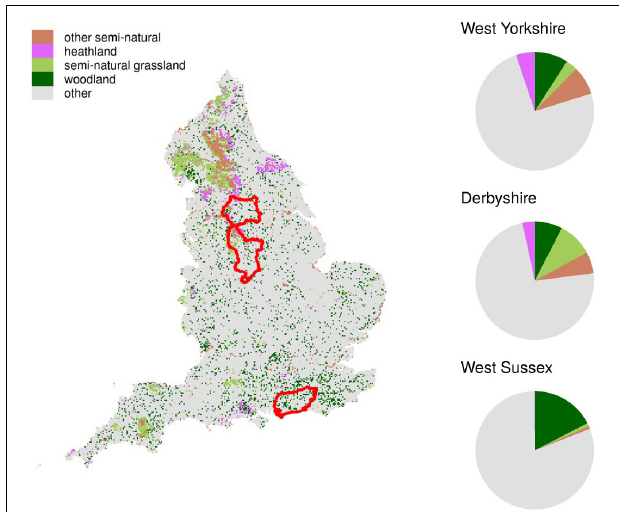
FIGURE 2 | Map of the study area. The red polygons show the three English counties selected in this study: West Yorkshire, Derbyshire and West Sussex (from North to South). Different color squares are 25 m grid cells with aggregated land cover classes as used in this study. Pie charts on the right show the proportion of 25 m cells in each land cover class for the three